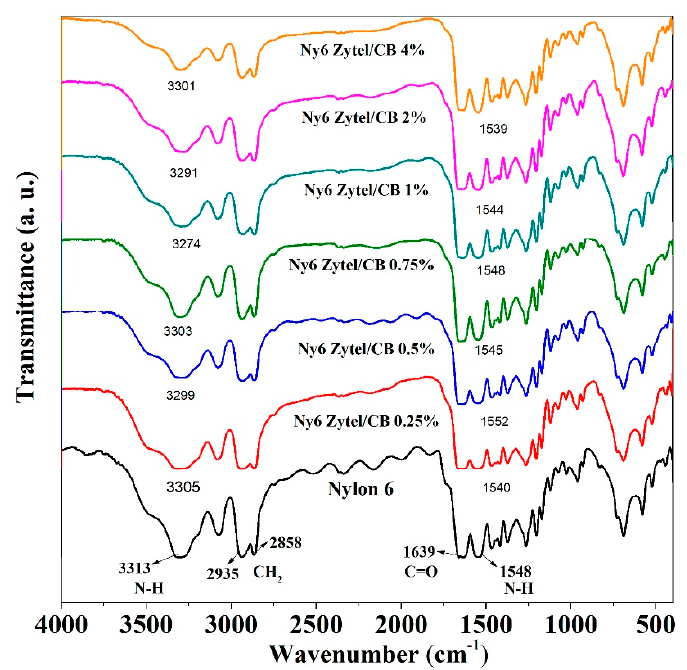
Figure 2. FT-IR spectra of Nylon 6 nonwoven fabrics and the samples obtained (0.25, 0.5, 0.75, 1.0, 2.0, and 4.0%).